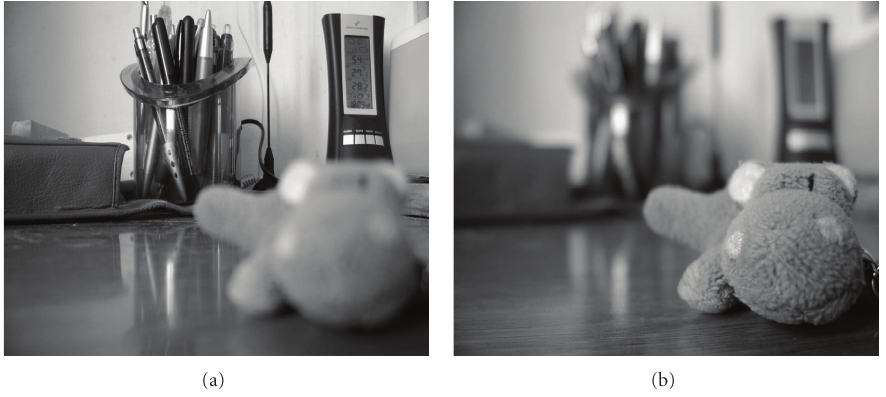
Figure 1: Two inputs of the image “Table.” The toy is blurred in the left image, and vice versa, it is the only sharp part in the right one.